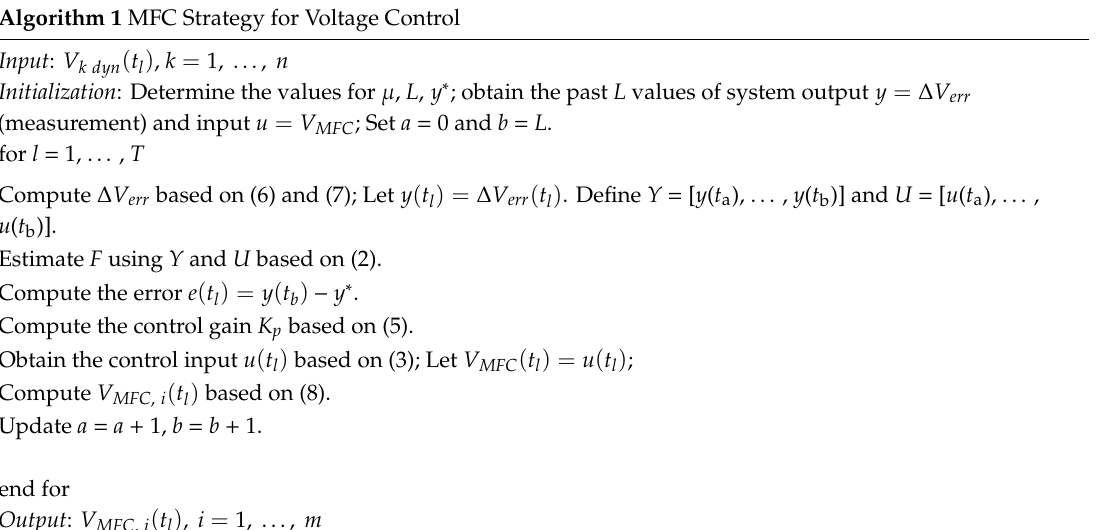
Algorithm 1 MFC Strategy for Voltage Control